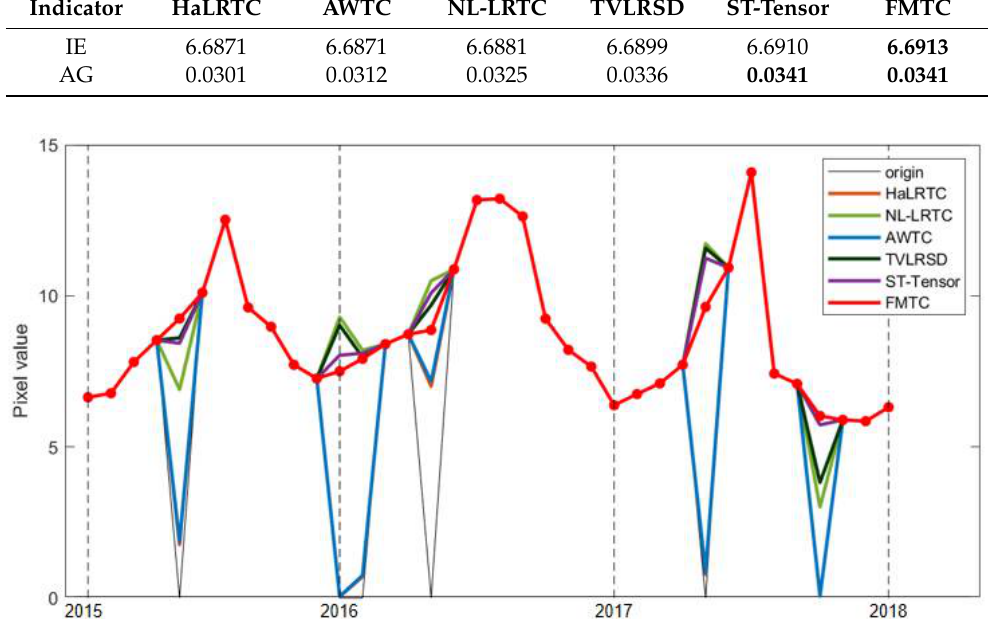
Figure 21. The time-series curves of six algorithms applied to one pixel from 2015 to 2017.